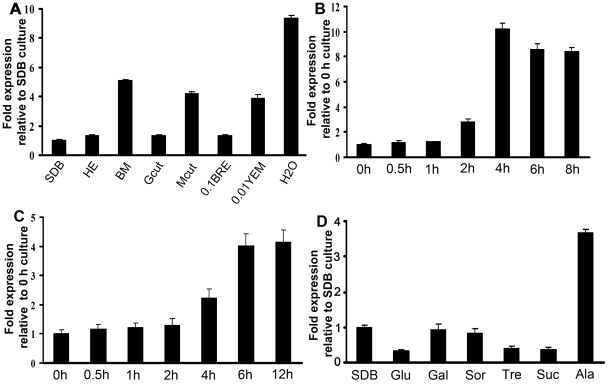

Mest1 expression in wild type Mr2575, as measured by quantitative real-time RT-PCR.(A) Analysis of Mest1 expression by wild type Mr2575 grown for 6 h in Sabouraud dextrose broth (SDB), cell-free hemolymph (HE), basal medium, 1% grasshopper cuticle (Gcut), 1% Manduca sexta cuticle (Mcut), 0.1% bean root exudates (BRE), 0.01% yeast extract medium (YEM) and water. Quantitative RT-PCR time course analyses of Mest1 expression by wild type M. robertsii Mr2575 incubated in (B) water for up to 8 h, or (C) 1% (w/v) ground M. sexta cuticle for up to 12 h. (D) Effect of sugars on Mest1 expression by Mr2575. Quantitative RT-PCR analysis of Mest1 expression by wild type Mr2575 grown in SDB or basal medium (BM) complemented with 1% glucose (Glu), 1% galactose (Gal), 1% sorbose (Sor), 1% trehalose (Tre), 1% sucrose (Suc) or 1% alanine (Ala). Culture conditions and RNA extraction were as described previously [38]. gfp and tef were used as reference genes.